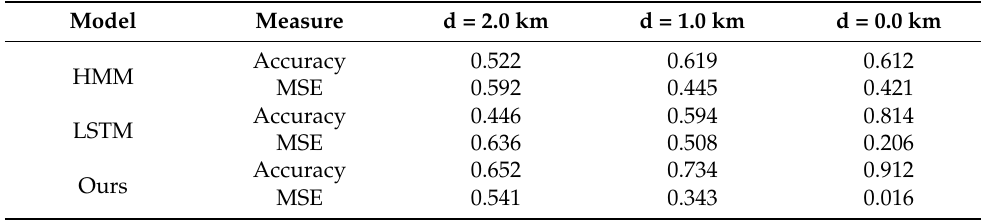
Table 2. Mean (variance) accuracy and MSE of intent prediction models at different distances to precautionary